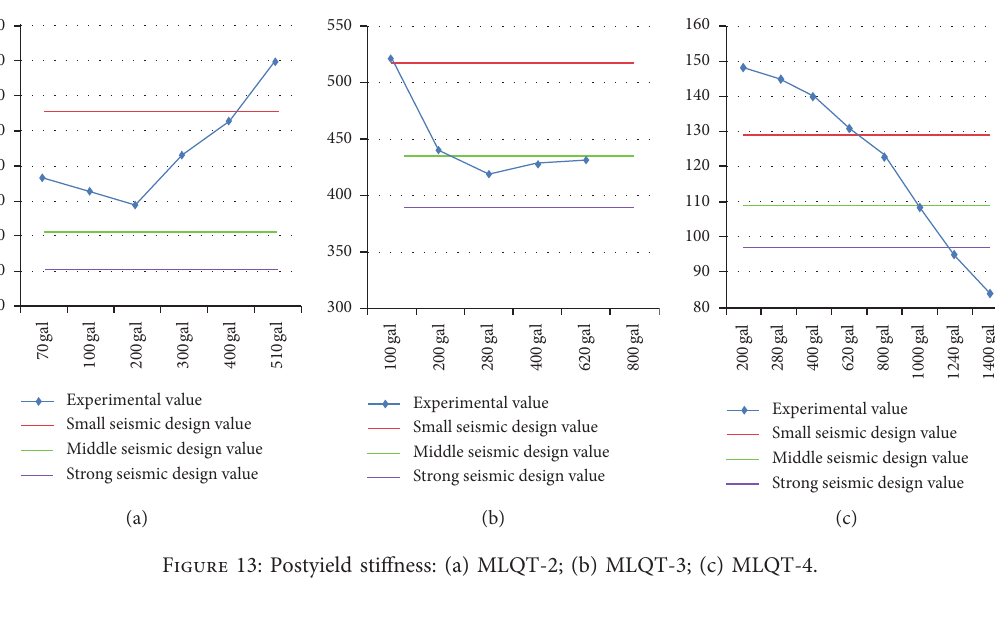
Figure 13: Postyield stiffness: (a) MLQT-2; (b) MLQT-3; (c)